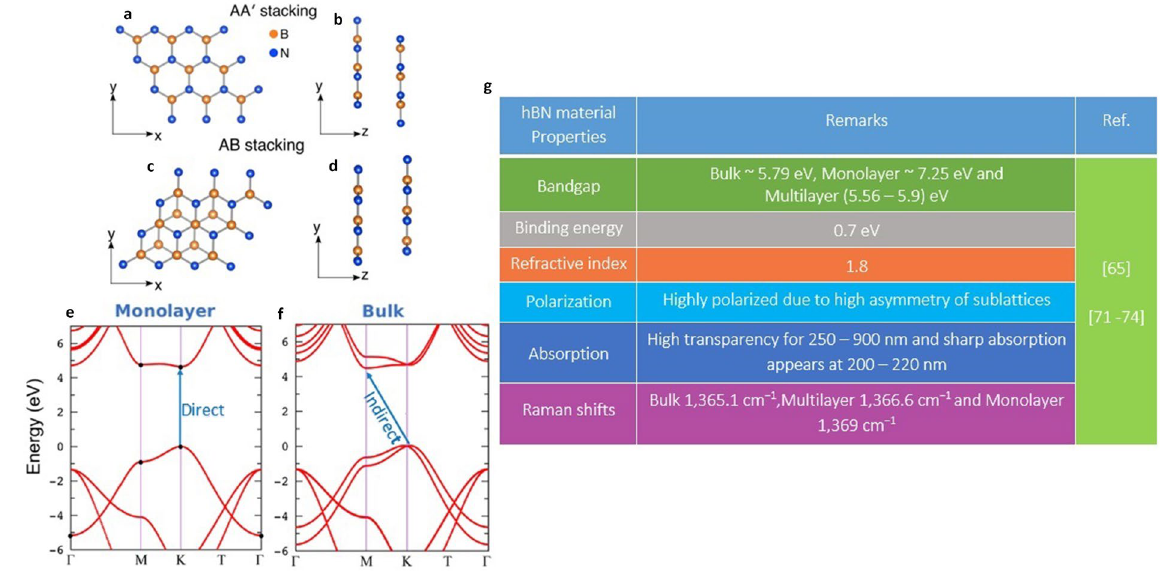
Figure 3. Schematic representation of hBN stacking 74 , electronic band structure of monolayer and Bulk hBN 75 and electrical/optical/crystal properties of hBN material. ( a , b ) Top view and side view of AA’ stacking. ( c , d ) Top view and side view of AB stacking. ( e , f ) Electronic band structure of monolayer and bulk hBN with direct and indirect bandgaps respectively. ( g ) General properties of hBN material and similar Raman shifts (around values) can be observed for high quality crystals.